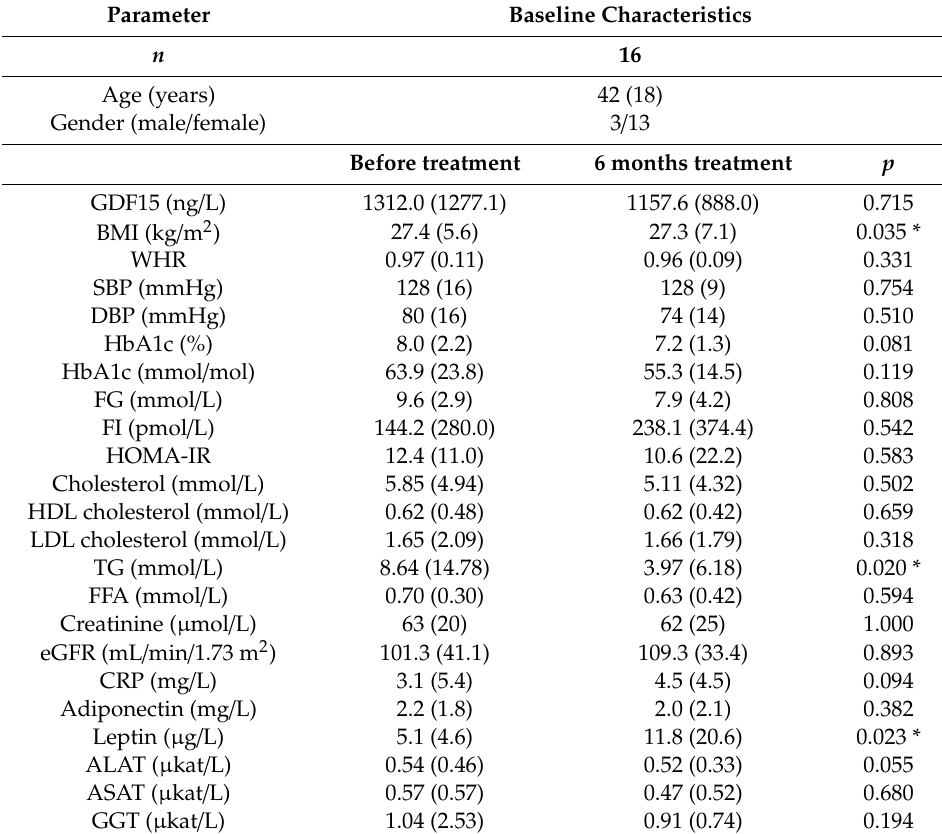
Table 3. Baseline characteristics, as well as parameters before and 6 months after initiation of metreleptin treatment in LD patients ( n = 16). Abbreviations are indicated in Table 1. Values for median (interquartile range) or absolute numbers ( n ) are shown. * indicates p < 0.05 as assessed by Wilcoxon signed rank